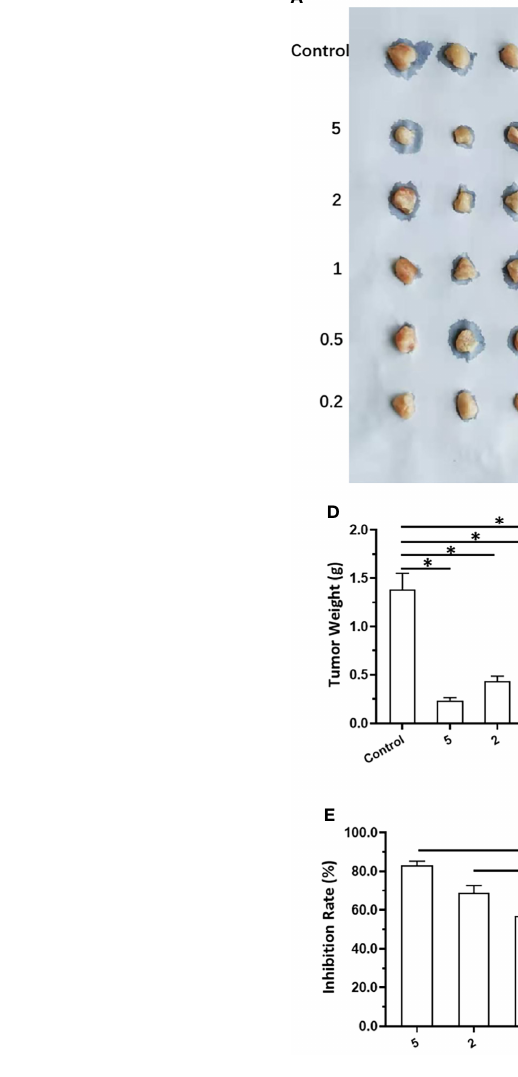
FIGURE 4 | The in vivo antitumor activation of SI-1 on MHCC97-H cells. The MHCC97-H cells were cultured and injected into the subcutaneous position to form the subcutaneous tumor tissues. Then, the mice were received the SI-1 (5mg/kg, 2 mg/kg, 1 mg/kg, 0.5 mg/kg, 0.2 mg/kg) via oral administration. The results were shown as images of tumors (A) , the tumor volumes (B) , the inhibitory rates according to the tumor volumes (C) , the tumor weights (D) , the inhibitory rates according to the tumor weights (E) , and the heat-map (F) . *P <